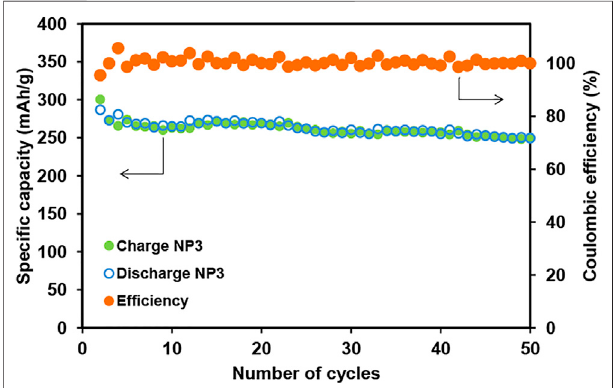
FIGURE 8 | Capacity retention and coulombic ef fi ciency for the NP3 electrodeduringthecyclingstabilitytestatacurrentrateofC/5.Note:10 wt% of GNPs is used in graphene-based electrodes; the total active material is 94.5